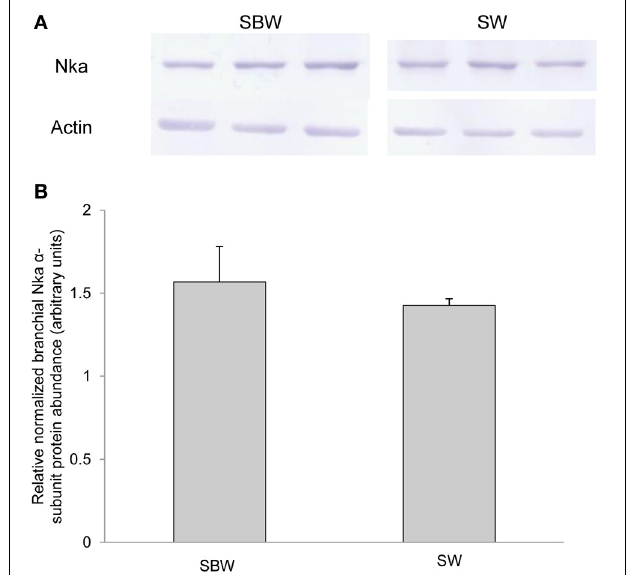
FIGURE 11 | Effects of exposure to seawater on Na + /K + -ATPase (Nka) protein abundance. Protein abundance of Nka based on the α 5 anti-NKA antibody which is known to react with all Nka/NKA α -isoforms of gills of Periophthalmodon schlosseri kept in slightly brackish water (SBW; salinity 3) for 2 weeks (control) or after 6 days of transfer from SBW to seawater (SW; salinity 30). (A) The immunoblots of Nka and actin. (B) The intensity of the Nka band was normalized with respect to that of actin. Results represent mean + s.e.m. ( N =